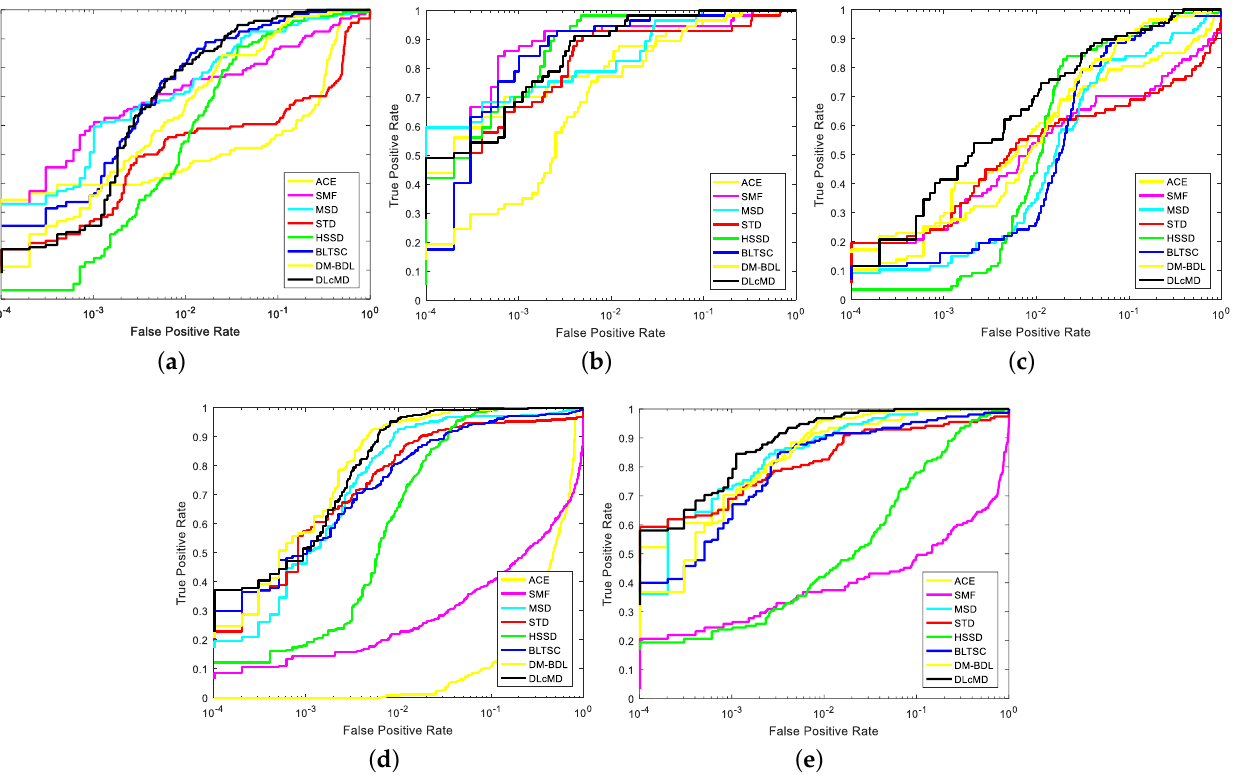
Figure 7. ROC curves of ( P d , P f ) on the five datasets. ( a ) San Diego − I. ( b ) San Diego − II. ( c ) Los Angeles − I. ( d ) Los Angeles − II. ( e ) Texas